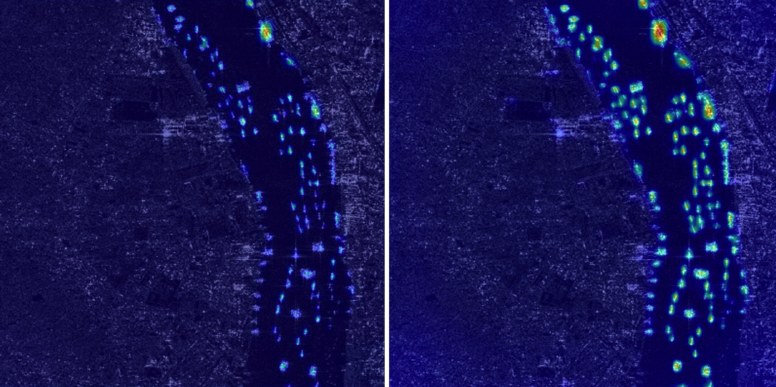
Figure 14. Feature activation heatmap w/o AFM.